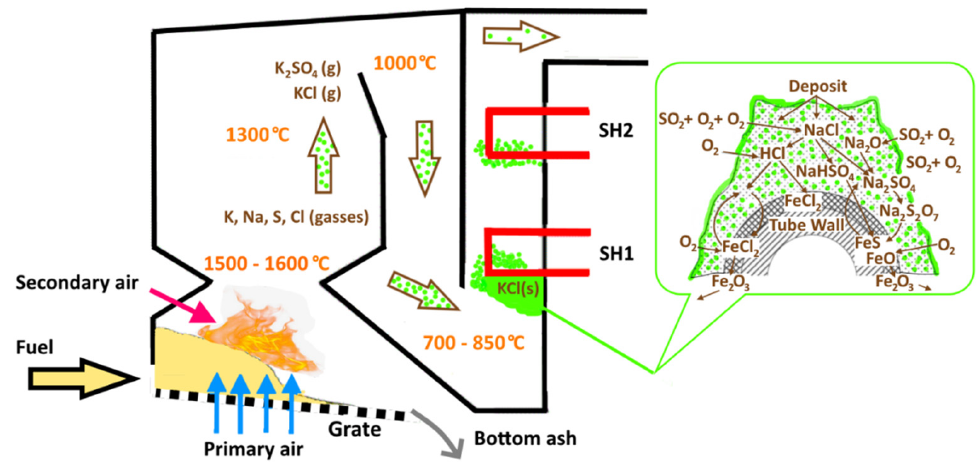
Figure 1. Fouling by KCl in a fixed bed straw boiler ( left ), with chloride and sulfide corrosion mechanism ( right )—adapted, based on [34,35] (SH1 and 2—sections of the superheaters in the boiler).